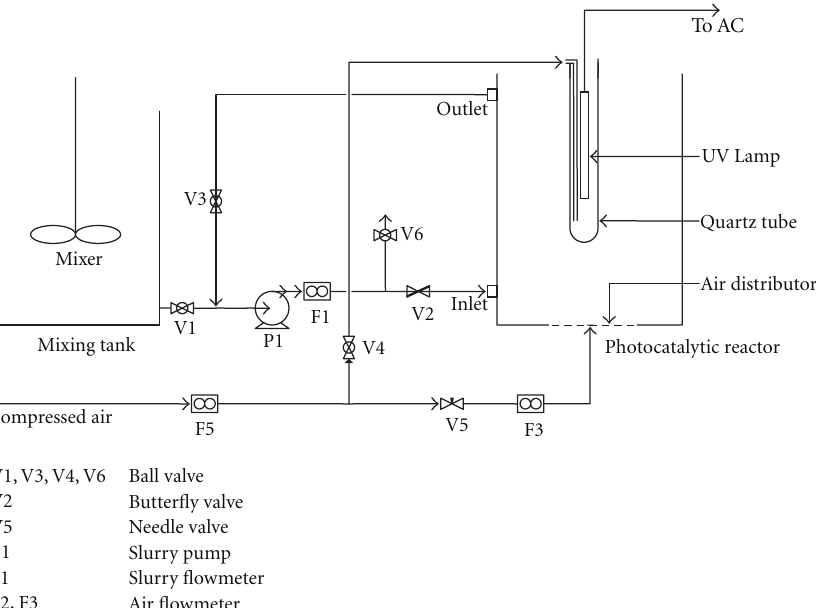
Figure 1: Experimental setup for photocatalysis experiments. Shower water was mixed for 30 minutes with catalyst and acid in mixing tank initially before mixture was sent to the photocatalytic reactor via pump P1. Reactor was operated in recirculation mode.